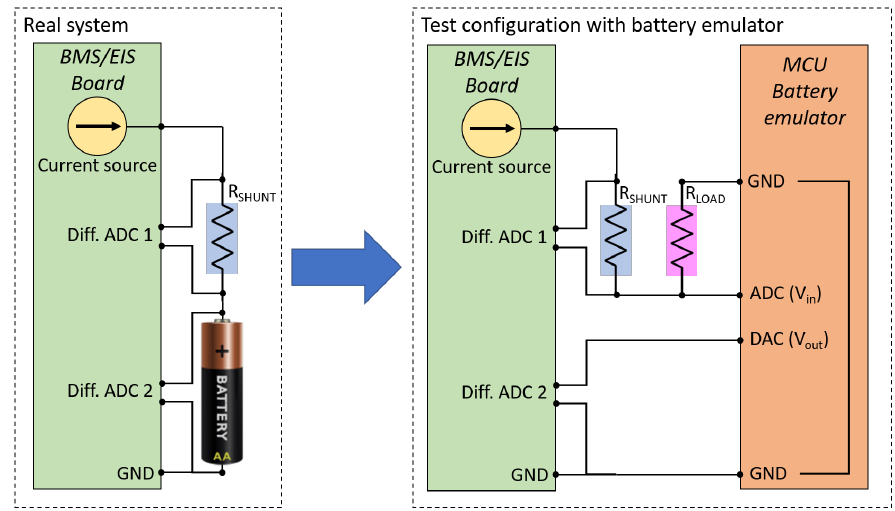
Figure 1. ( Left ): The scheme of the actual EIS measurement system connected to a battery. ( Right ): the same EIS instrument, but connected to the battery emulator implemented by means of a micro- controller unit provided with a unipolar ADC and a DAC.